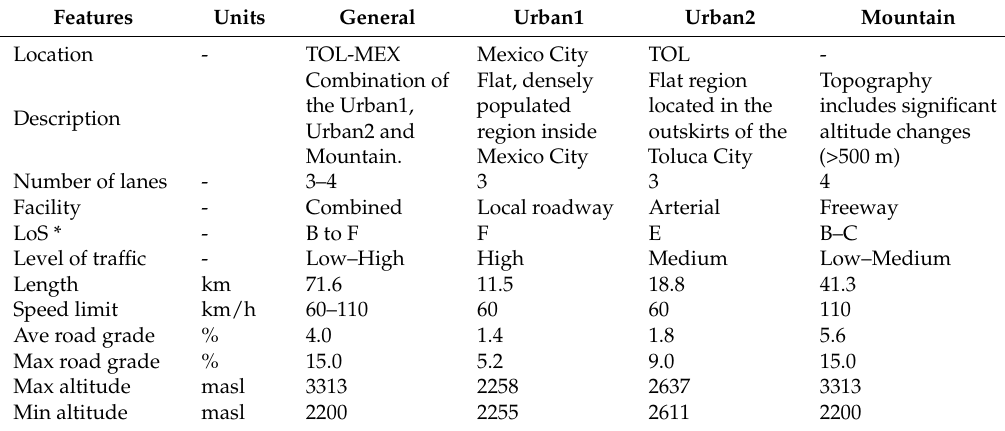
Table 1. Description of the regions considered in this work. Taken from Huertas et al. [14].